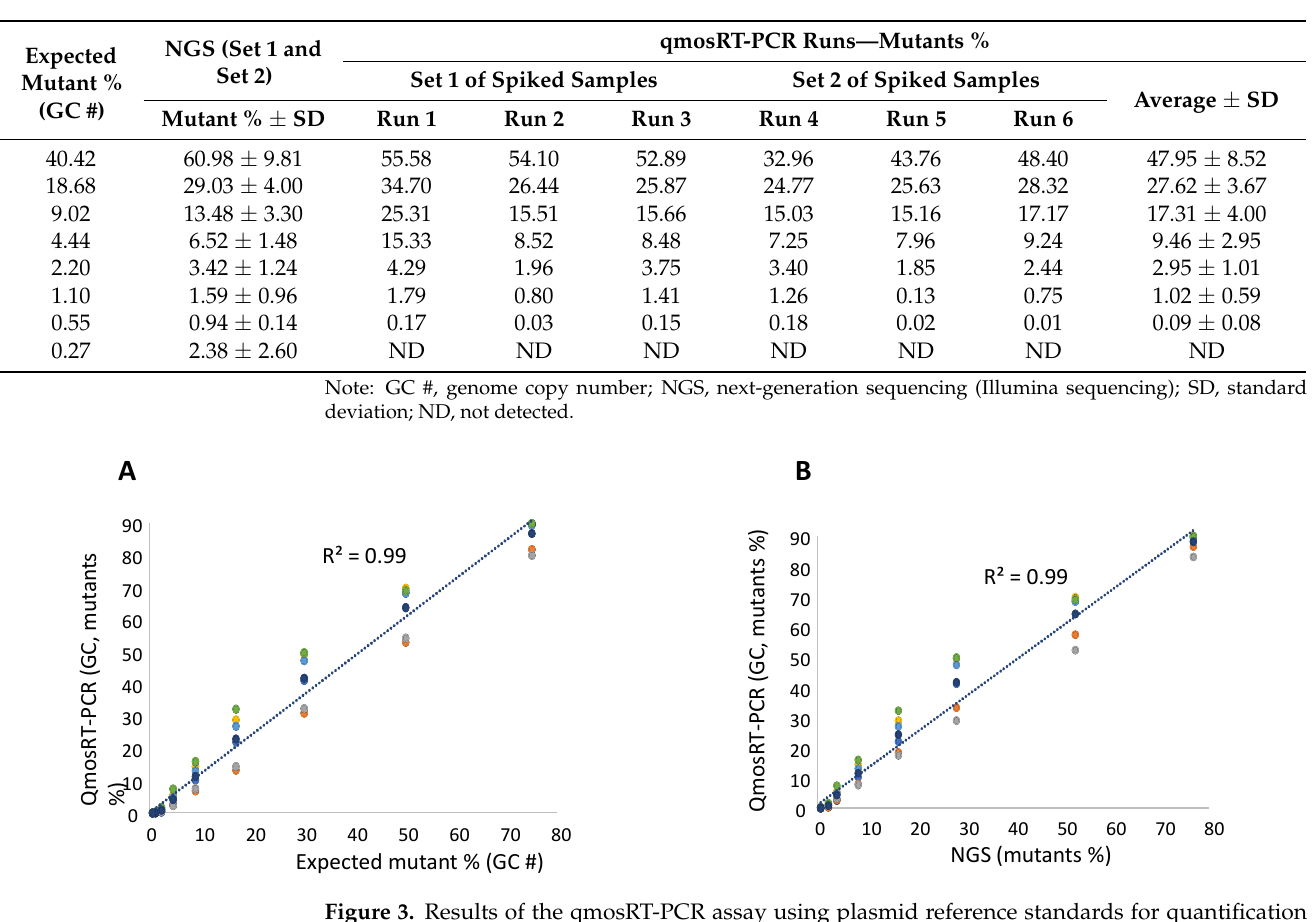
Table 5. Quantification of nOPV2-c1_143 mutants in the virus-spiked samples with qmosRT-PCR assay using plasmids as reference standards.